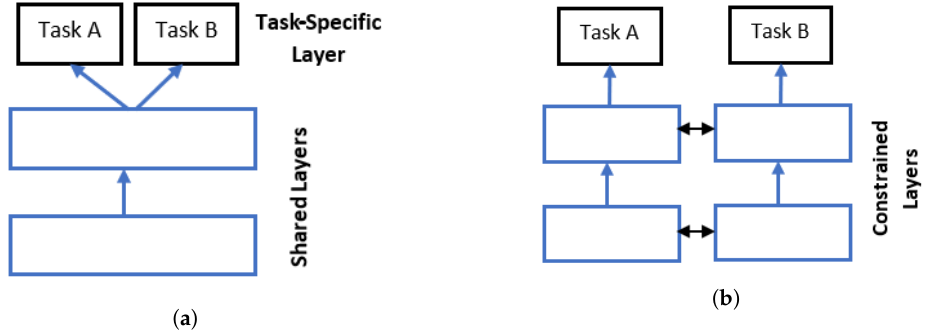
Figure 2. Hard-parameter- vs. soft-parameter-shared MTMs: ( a ) hard-parameter-shared MTM; ( b ) soft-parameter-shared